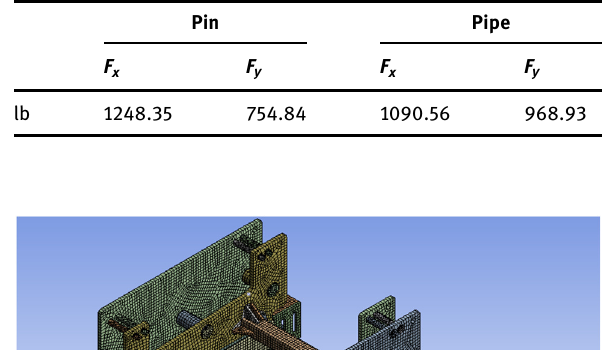
Table 3: Equivalent loads on pin and pipe for input torque during make - up and break - up